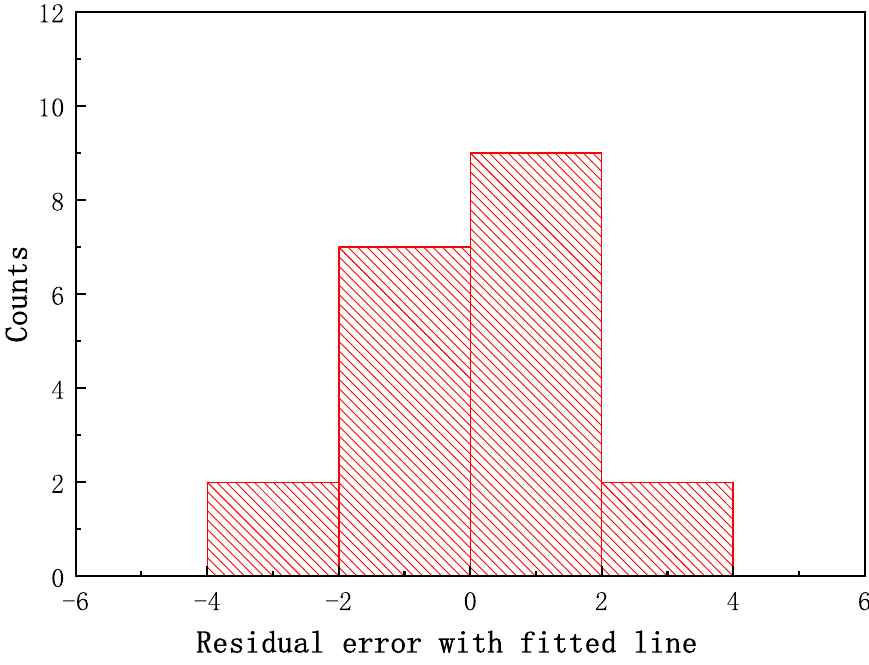
Figure 12. Residual distance and quantity statistics